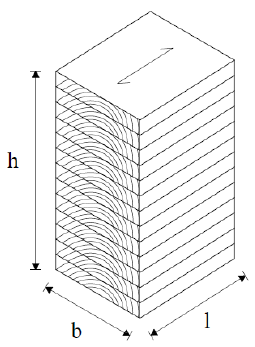
Figure 17. Sample for compression test.